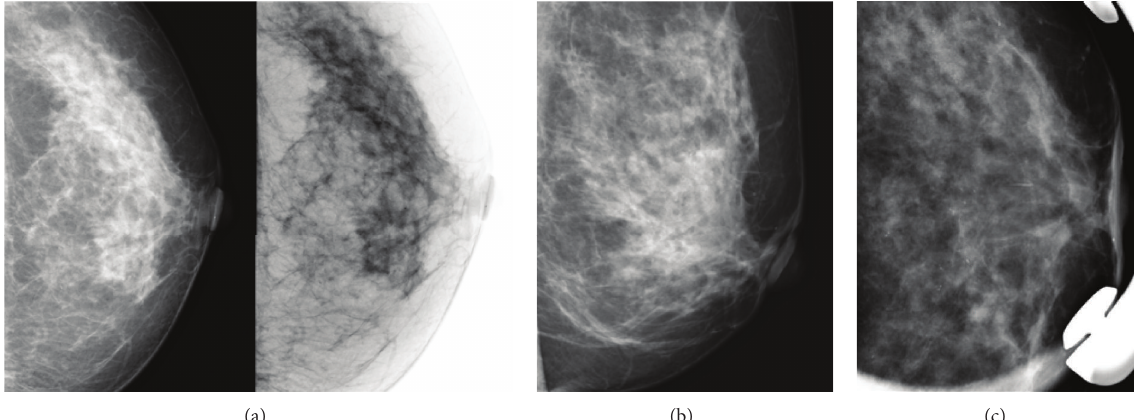
Figure 1: Left craniocaudal projection (a), medio-lateral oblique projection (b), and magnification view (c) show numerous and inhomo- geneous microcalcifications in the subareolar region, not associated to underlying mass, architectural distortion, and nipple retraction.